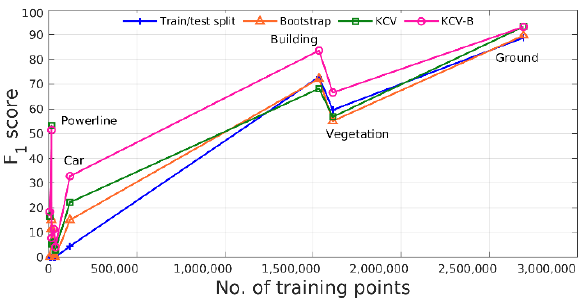
Figure 5. Experiment 1; F I -score results plotted solely as a function of available training data